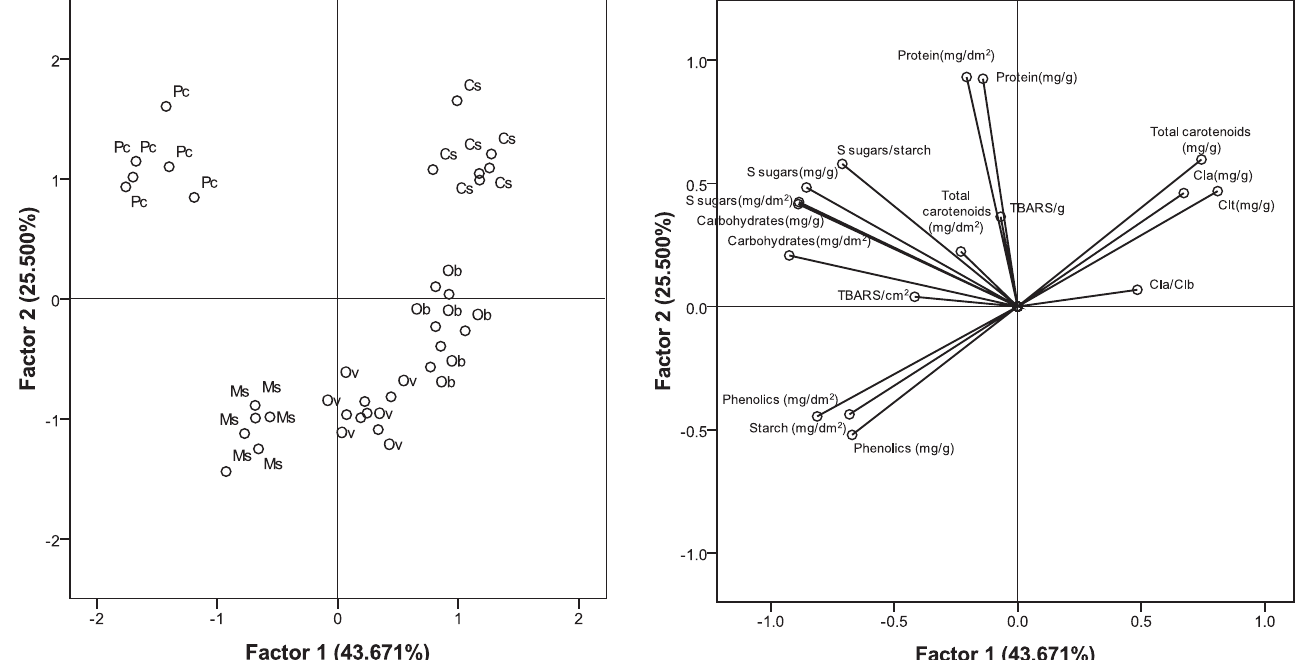
Fig. 4: Pr incipal component analysis obtained from the significant different data of biochemical parameters of five different aromatic and medicinal plants (Cs – Coriandrum sativum L.; Ms – Mentha spicata L.; Ob – Ocimum basilicum L.; Ov – Origanum vulgare L.; Pc – Petroselinum crispum Mill.). PCA factors explain 82.692% of the total